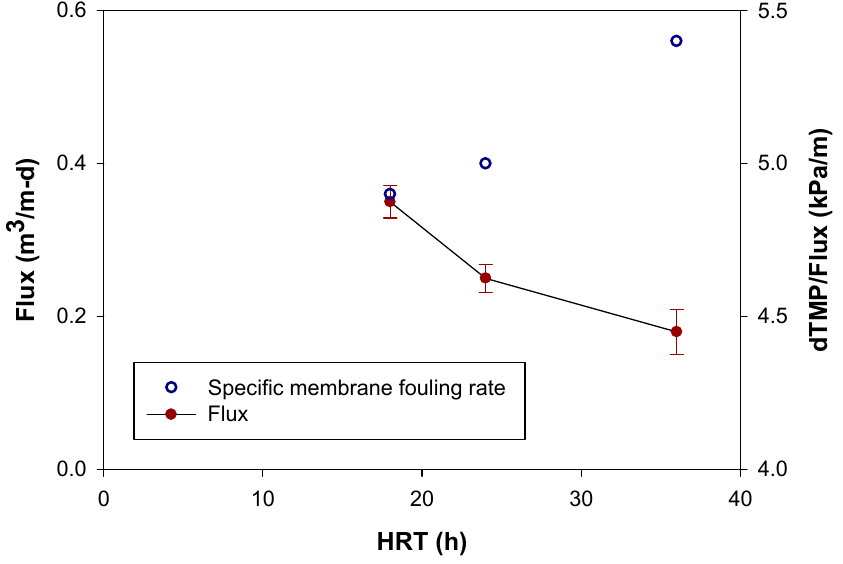
Figure 7. Effect of HRT on Membrane fouling rate and flux.